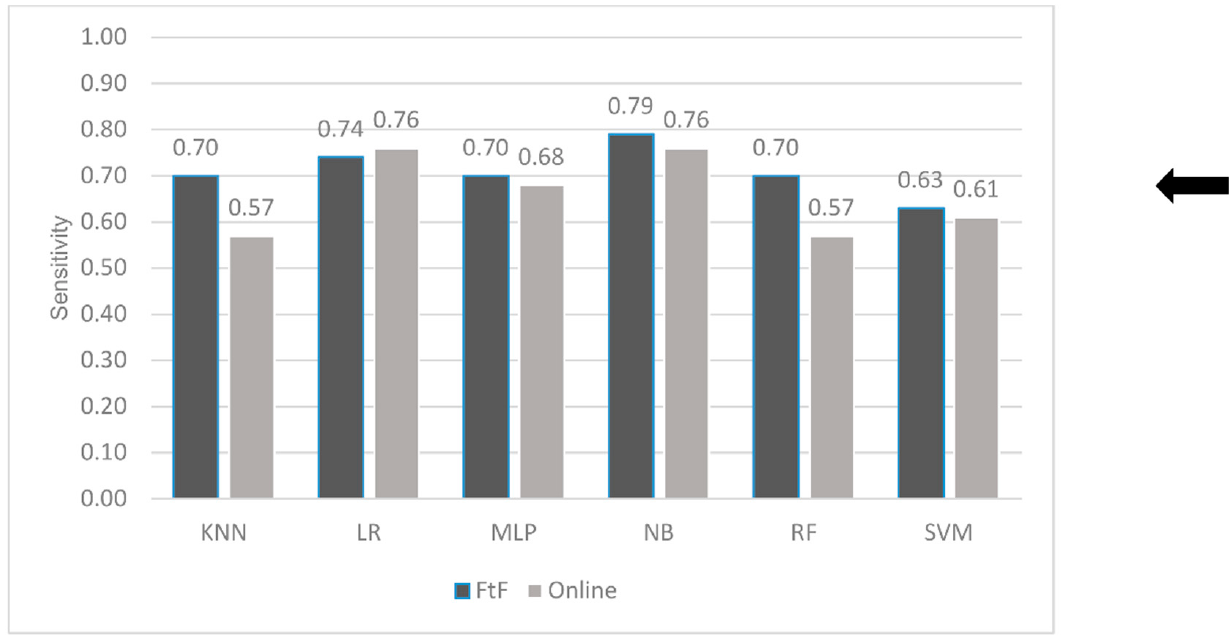
Figure 5. WED course: prediction of at-risk students (sensitivity scores) by instructional